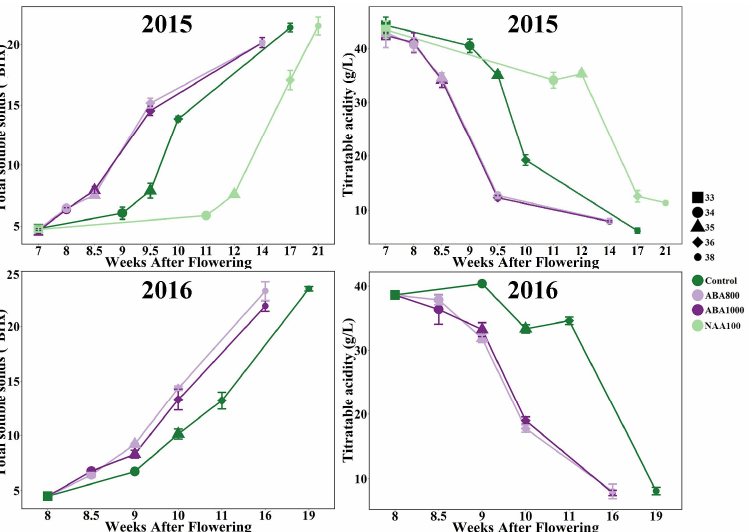
Figure 1. Total soluble solids and titratable acidity in two consecutive seasons. The different shape represents the phenological stage: square (E-L 33 stage), big circle (E-L 34 stage), triangle (E-L 35 stage), rhombus (E-L 36 stage), small circle (E-L 38 stage). The lines of green, light purple, purple and light green represent Control, 800 mg/L abscisic acid (ABA) (ABA800), 1000 mg/L ABA (ABA1000), and 100 mg/L synthetic auxin 1-naphthaleneacetic acid (NAA) (NAA100), respectively. Bars represent ± standard deviation.